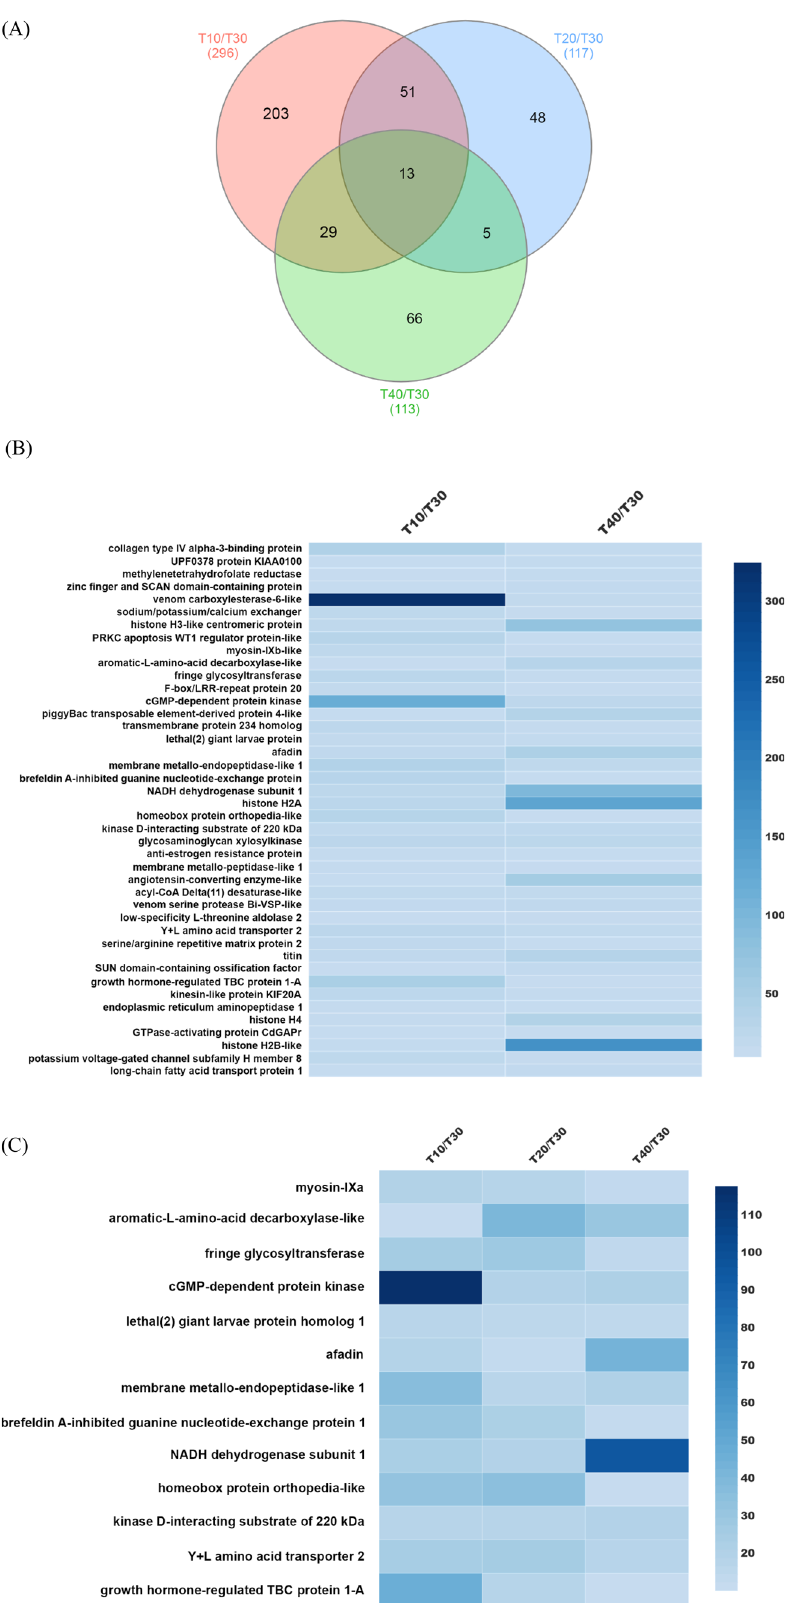
Figure 4. Distribution of the same Differentially Expressed Genes (DEGs) between treatment groups. ( A ) The venn diagram represents the same unigenes (log 2 FC ≥ 10) between all three groups in comparison with T30 as control. ( B ) Heatmap shows expression patterns for same DEGs (p-value < 0.05, log 2 FC ≥ 10) involved in low (10 °C) and high (40 °C) temperature treatment groups in comparison with T30 as control. ( C ) Heatmap represents expression of the same DEGs (p-value < 0.05, log 2 FC ≥ 10) involved in all three groups of temperature treatment groups compared with T30 as